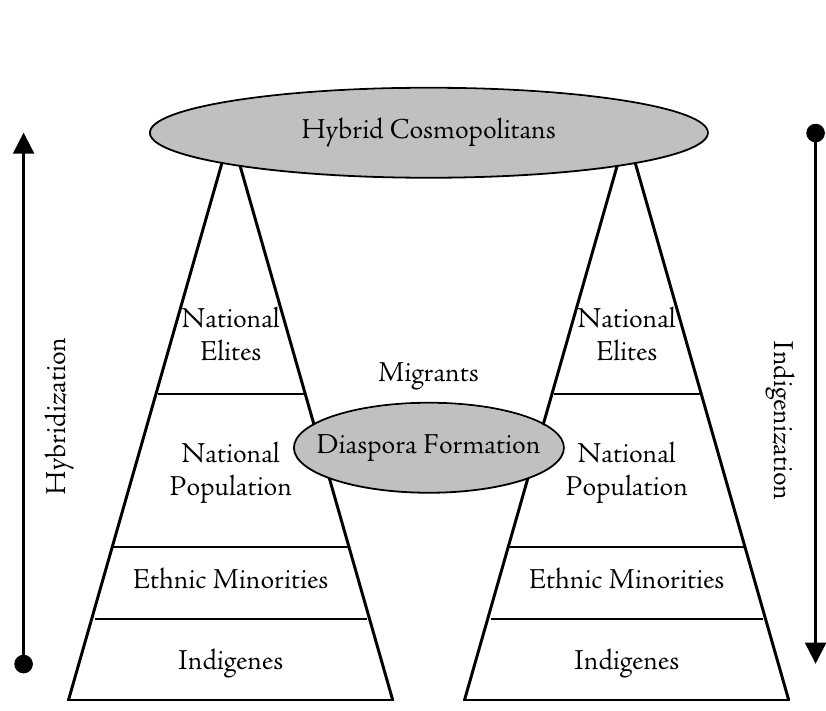
Figure 1: Cosmopolitanization and indigenization in the contemporary global